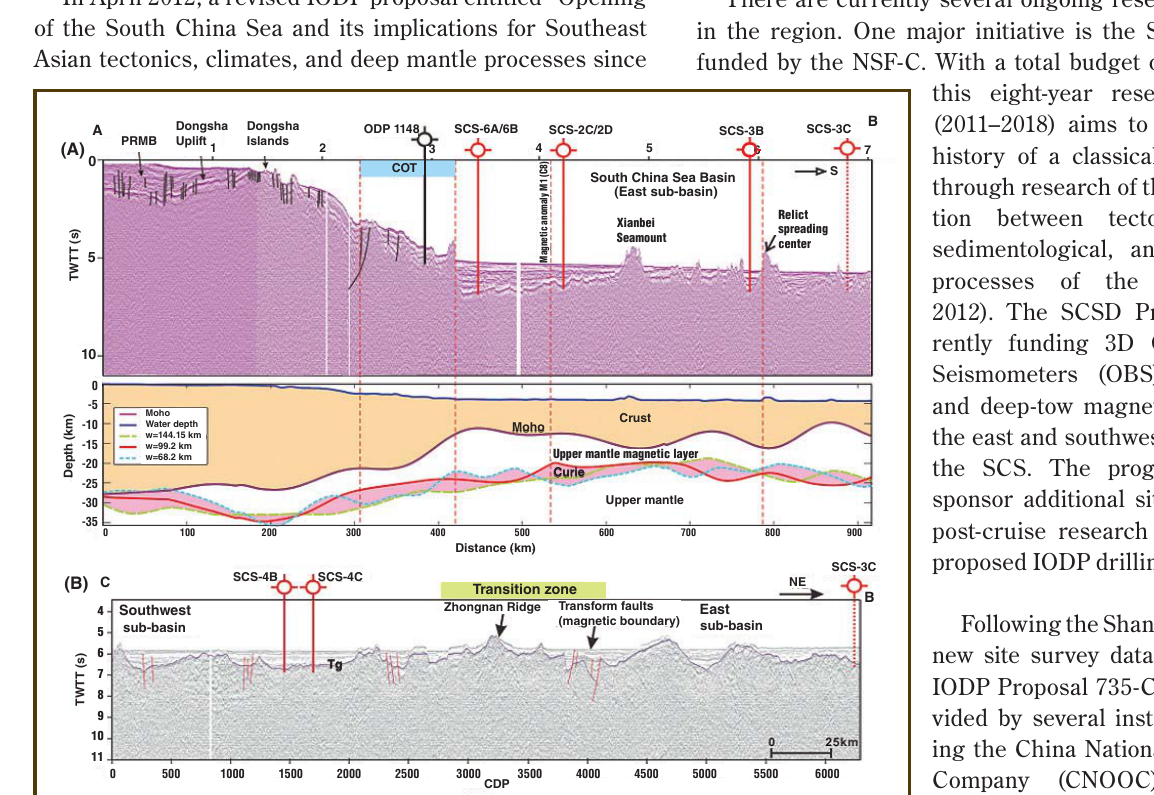
Figure 3. [A] (upper) Proposed sampling transect in the east sub-basin of the SCS (after Li et al., 2010). (lower) The Moho and Curie depths estimated from gravity and magnetic anomalies, respectively. TWTT=two-way travel time. COT=continent-ocean transition zone. PRMB=Pearl River Mouth Basin. w=width of moving windows in estimating Curie depths. [B] Seismic section showing the structures of the southwest sub-basin and the east sub-basin, as well as the transition zone between them. Tg is the Cenozoic basement (after Li et al.,